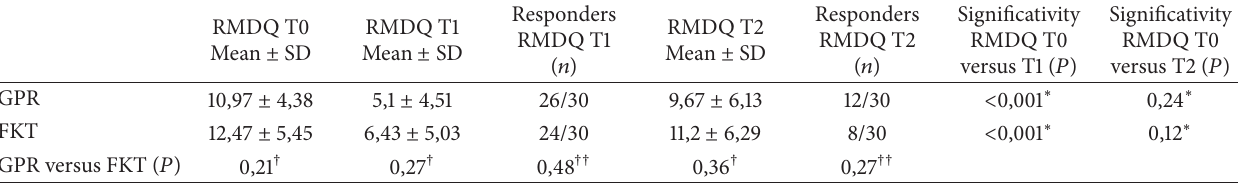
Table 3: Differences in RMDQ results per group before, after and between groups.